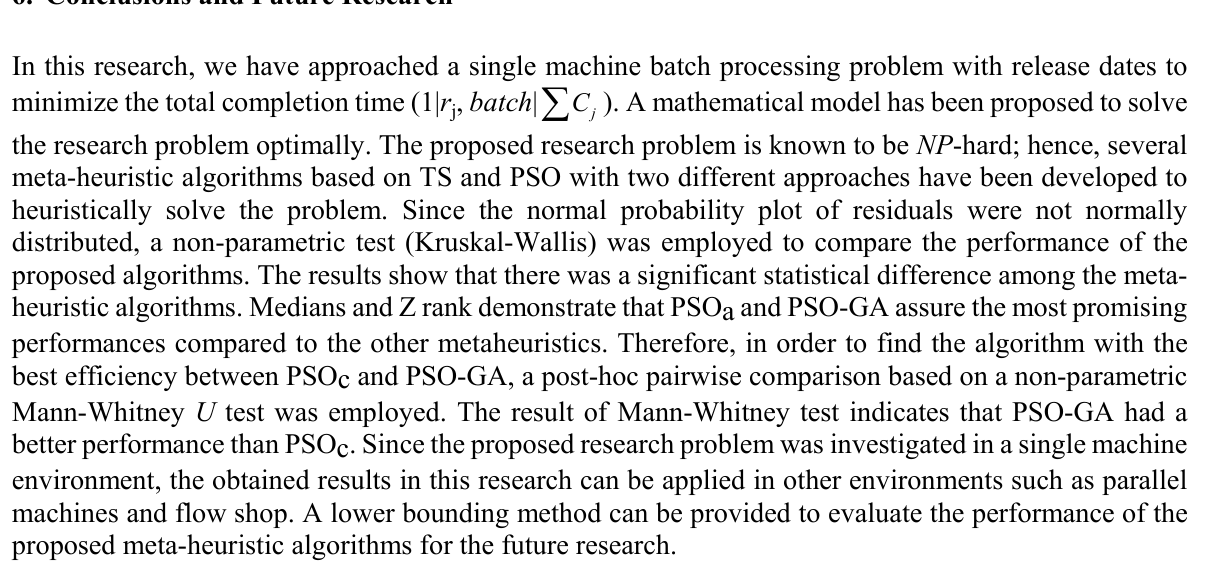
Comparison between PSO-GA and PSO-TS: Test of Mann Whitney ALGO N Median PSO-GA 486 0.000000000 PSOc 486 0.000000000 Point estimate for η 1 - η 2 is -0.00000 95.0 Percent CI for η 1 - η 2 is (-0.00001; 0.00000) W =